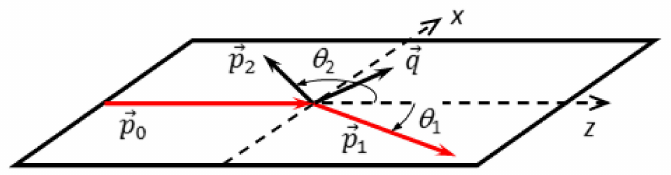
Figure 2. The coplanar scattering geometry. For details see